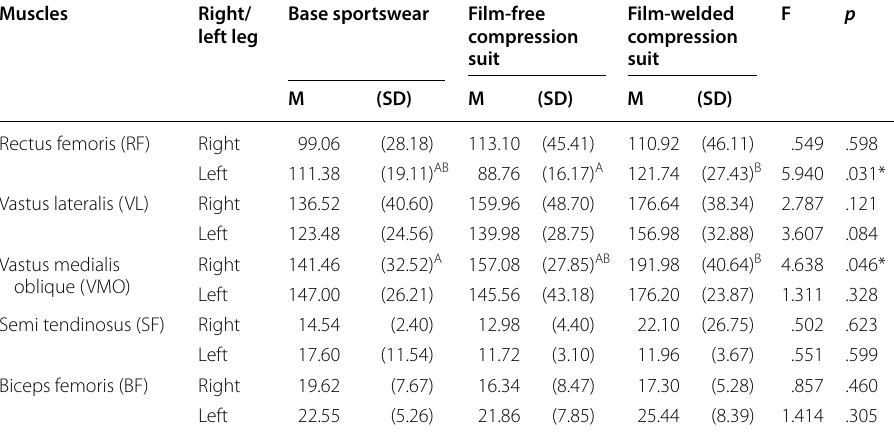
A–B Different alphabet indicates significant difference by Tukey *p <